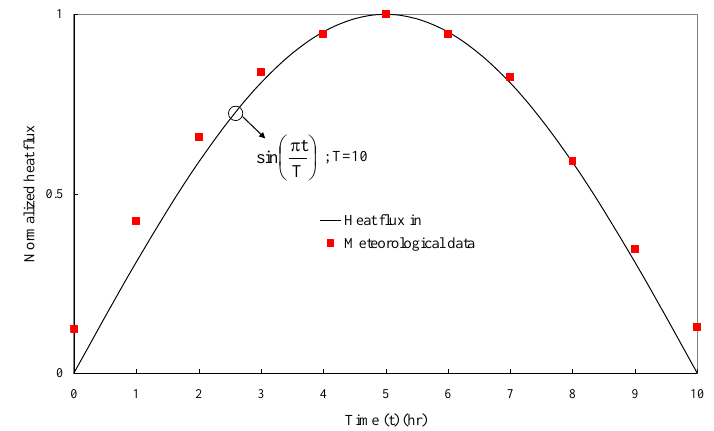
Figure 4. Normalized heat flux input and measured meteorological data.